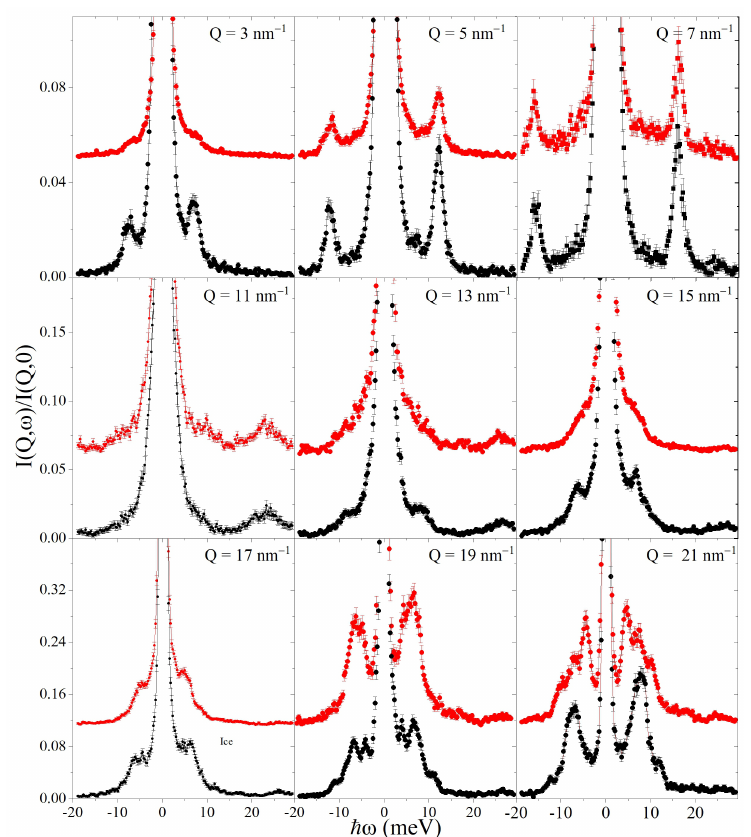
Figure 3. IXS spectra from the ice samples (black dots) at the indicated Q values are compared with those of the frozen suspension (red dots). Spectra are normalized to their maximum and represented in an expanded y -scale to emphasize the shape of the inelastic features. Spectra from the frozen suspension are vertically offset for